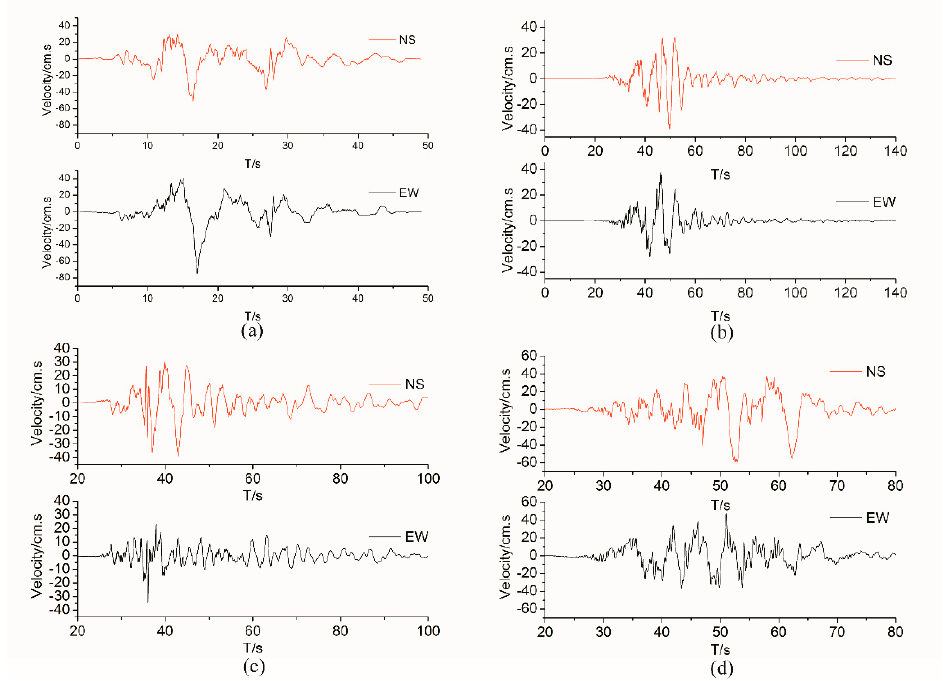
Figure 5. The recorded horizontal velocity time–histories: ( a ) station TCU101, ( b ) station TCU131, ( c ) station CHY029, and ( d ) station TCU070. Appl. Sci. 2018 , 8 , x FOR PEER REVIEW